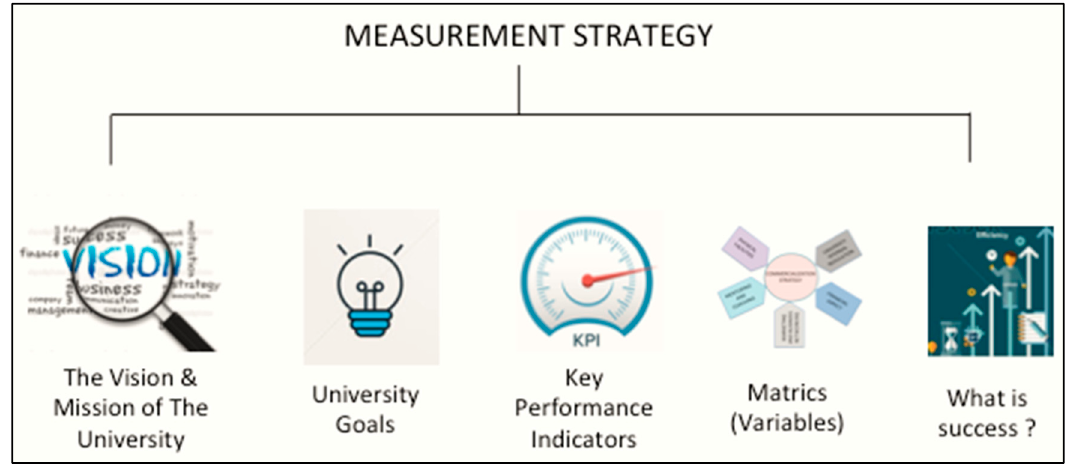
Figure 1. Measurement strategy.